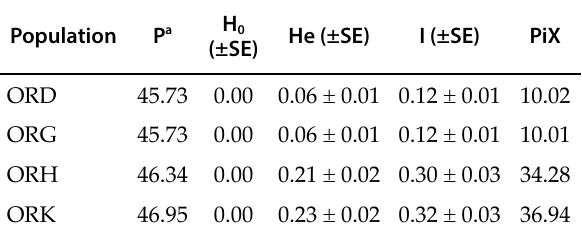
Table 3. Analysis of molecular variance in a set of four pop- ulations of sunflower broomrape populations (ORD, ORH, ORG, ORK) collected in Tunisia.